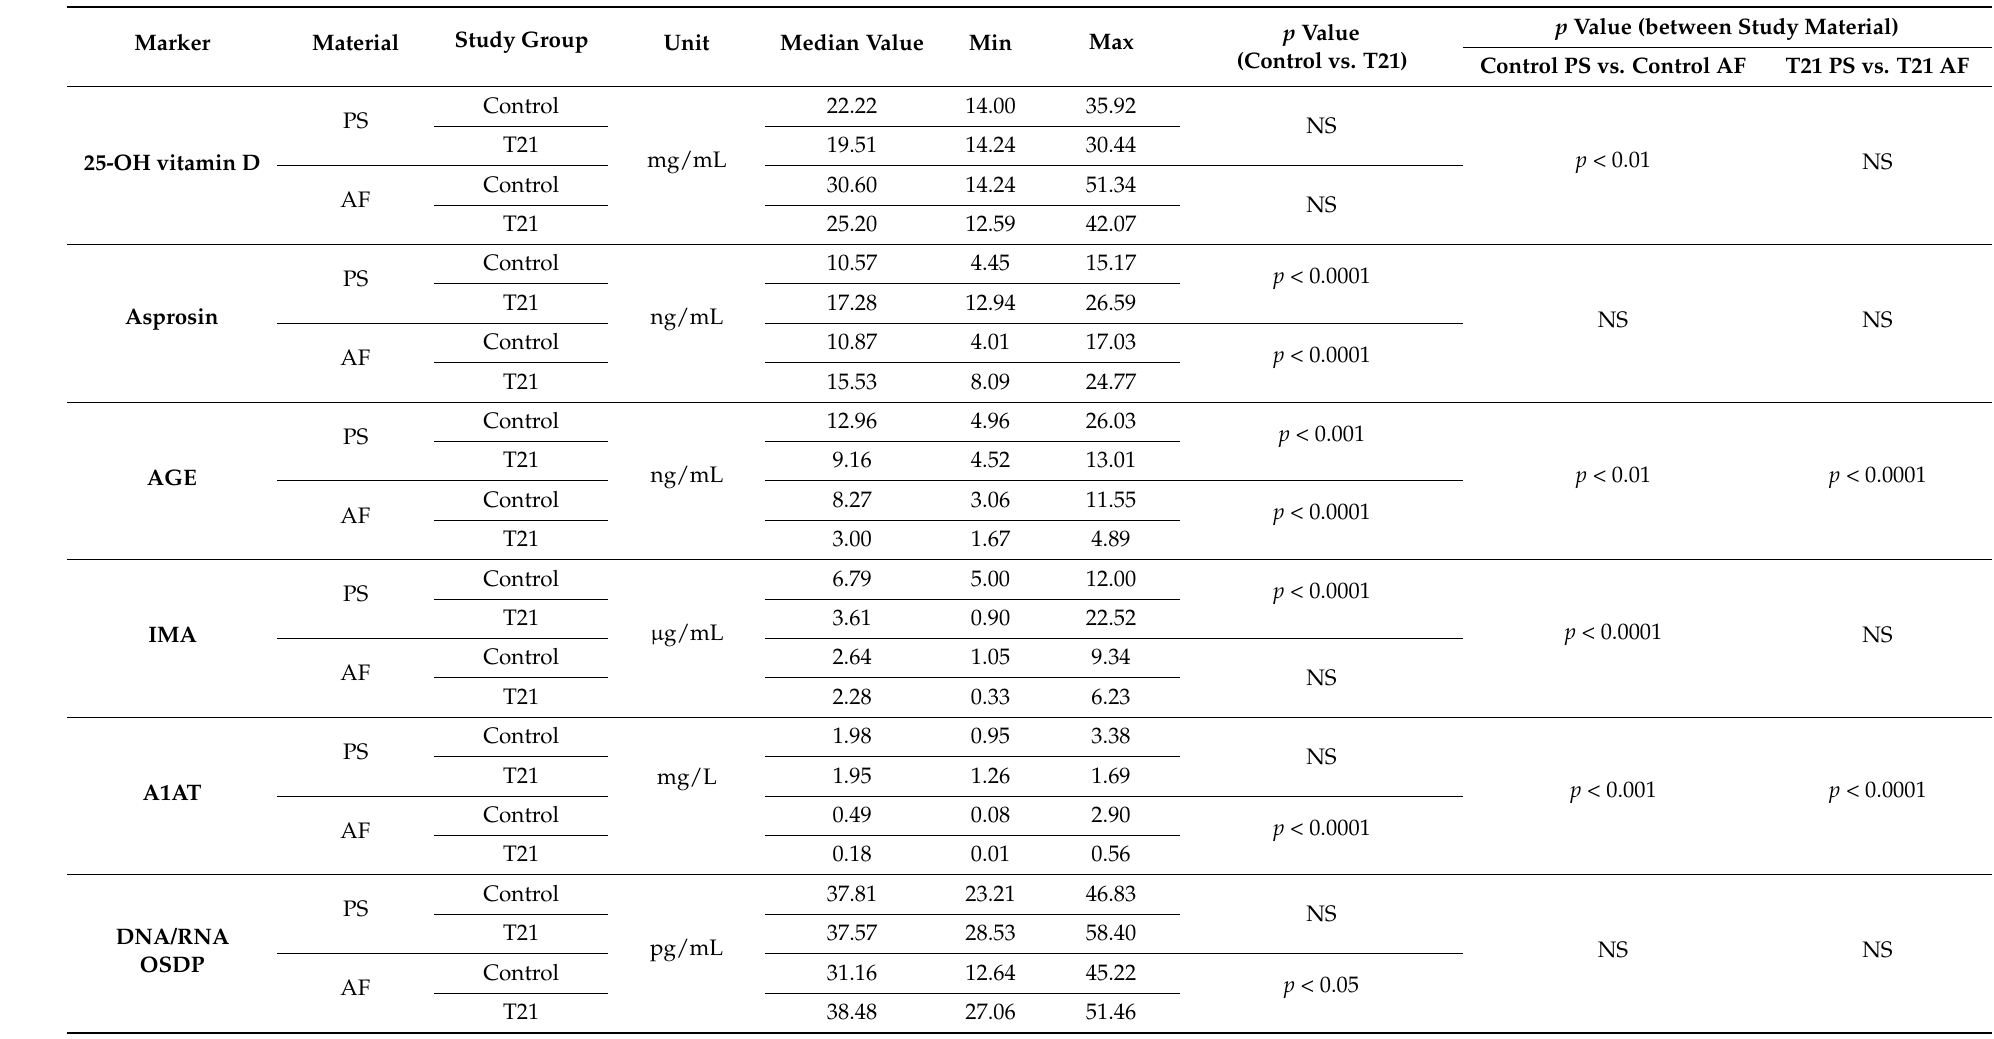
Table 1. Basic statistics and comparison of studied protein concentrations measured in the plasma and amniotic fluid